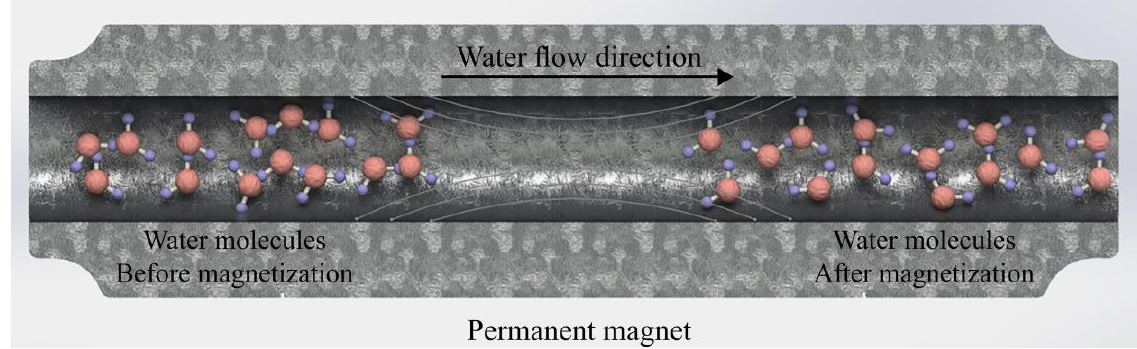
Figure 1. Effect of magnetic field on water molecule clusters.